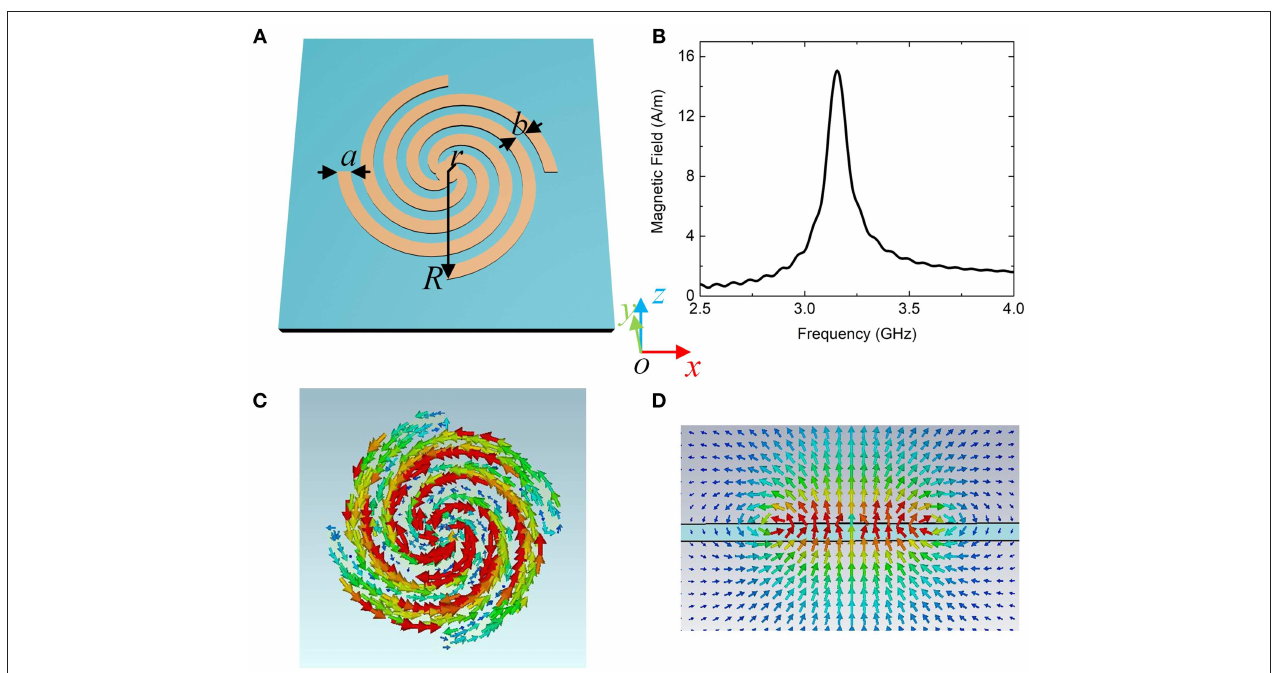
FIGURE 1 | (A) Schematic of the metallic spiral structure. (B) Magnetic field amplitude intensity detected at the center of the resonator. (C) Current distribution at z = 0. (D) Magnetic field vectors at x =